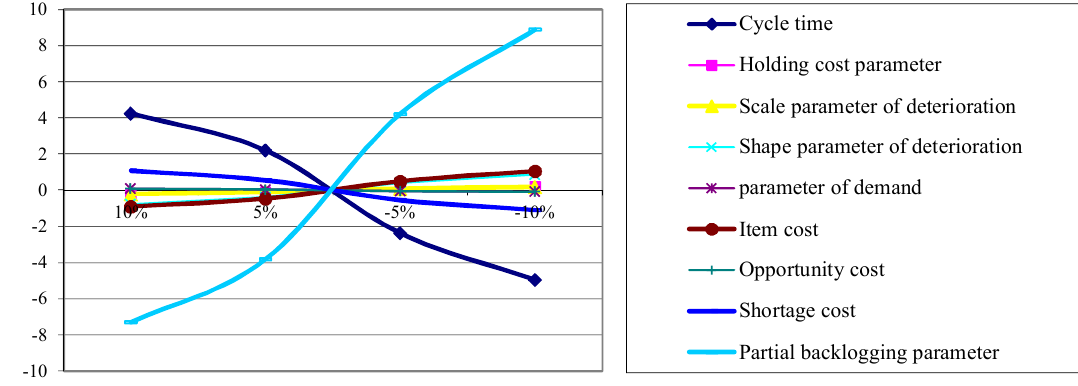
Fig. 6. Behavior of optimal ordering quantity in scenario